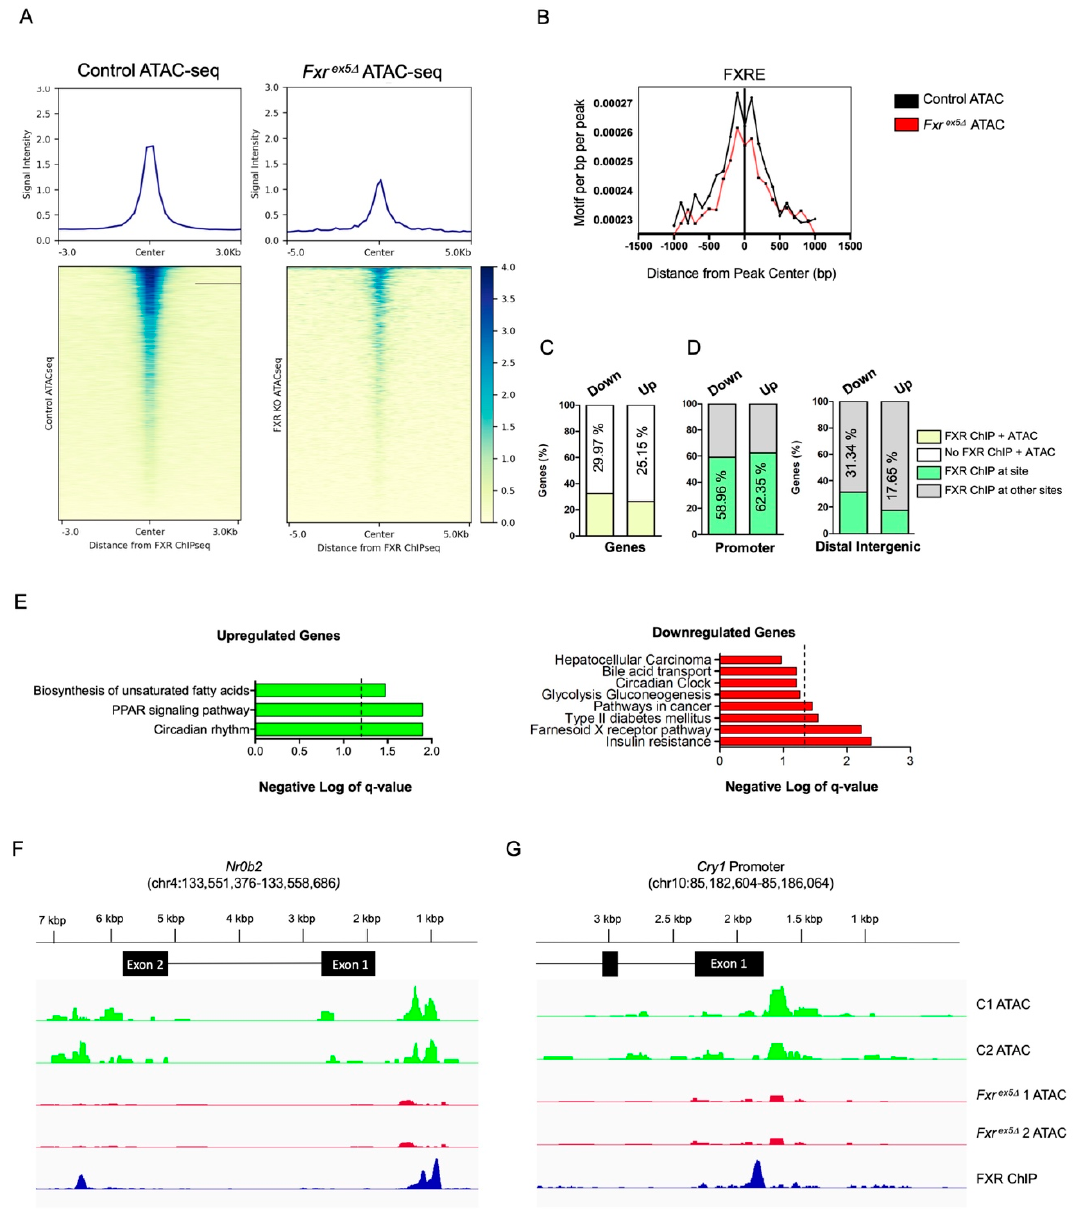
Figure 4. FXR deletion leads to loss of chromatin accessibility and transcriptional dysregulation of genes from the circadian and insulin pathways. ( A ) The FXR ChIP-seq peak tracks were overlapped with ATAC-seq peaks from control and Fxr ex5 Δ samples. The heatmap depicts intensity of FXR bind- ing at sites of chromatin accessibility. ( B ) Motif de-enrichment plot for the FXR consensus motif for control and Fxr ex5 Δ hepatocytes. ( C , D ) Overlap between downregulated (447) and upregulated (338) genes that have an FXR binding site and are undergoing changes in chromatin accessibility upon FXR deletion in hepatocytes. Annotation of FXR ChIP-seq peak summits at genes that are both dysregulated upon FXR deletion and with changes in chromatin accessibility ( D ). ( E ) Pathway anal- ysis of upregulated and downregulated genes that are both bound by FXR and undergoing changes in chromatin accessibility. The dotted line represents a FDR value of 0.05. Any value on the right of the dotted line signifies pathways that pass the FDR threshold of 0.05. ( F , G ) Browser view of the Nr0b2 ( F ) and Cry1 ( G ) loci showing control and Fxr ex5 ∆ ATAC-seq normalized tracks alongside of FXR ChIP-seq peaks. These genes are relevant to the circadian rhythm, bile acid biosynthesis and insulin signaling pathways, respectively.